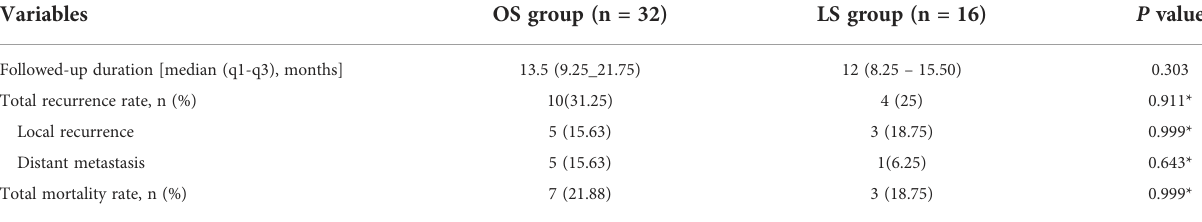
TABLE 4 Long-term outcomes in the OS and LS